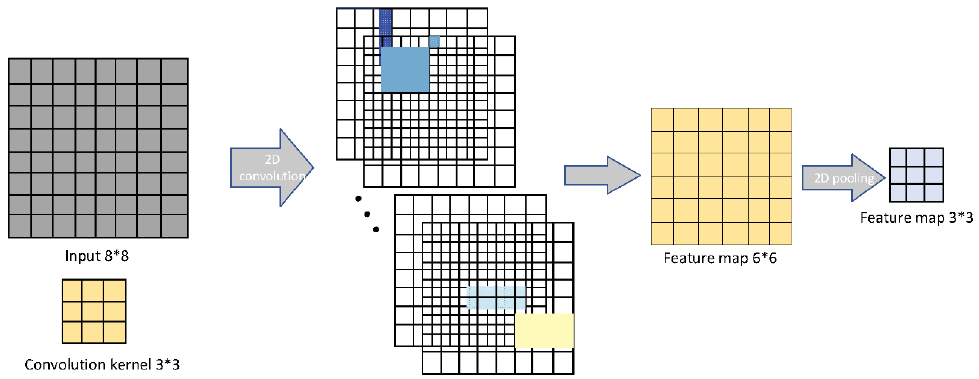
Figure 4. The process of the two-dimensional CNN.